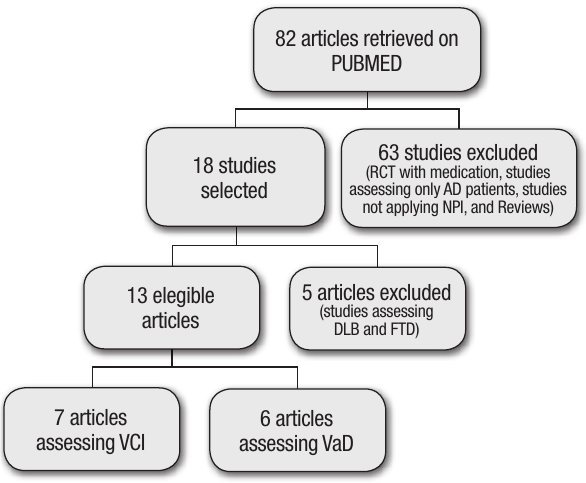
Figure 1. Flowchart of search strategy and article selection.